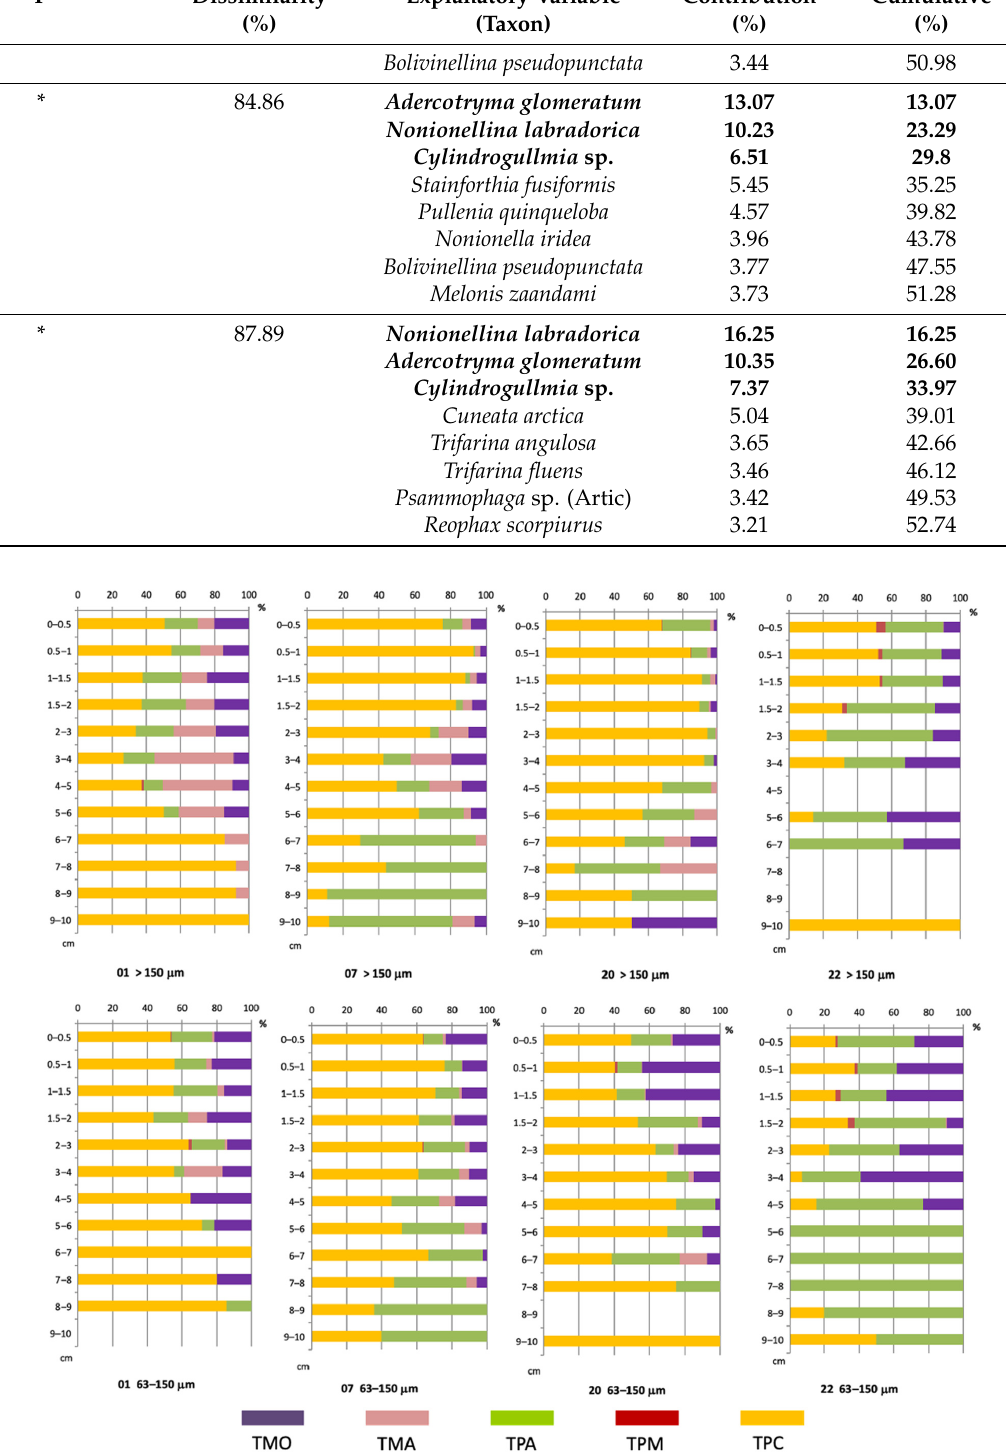
Figure 6. Relative abundance (%) of the different taxonomic components of foraminiferal assemblages in the four sampling sites. TMO = Total Monothalamous Organic; TMA = Total Monothalamous Agglutinated; TPA = Total Polythalamous Agglutinated; TPM = Total Polythalamous Miliolids; TPC = Total Polythalamous Calcareous.